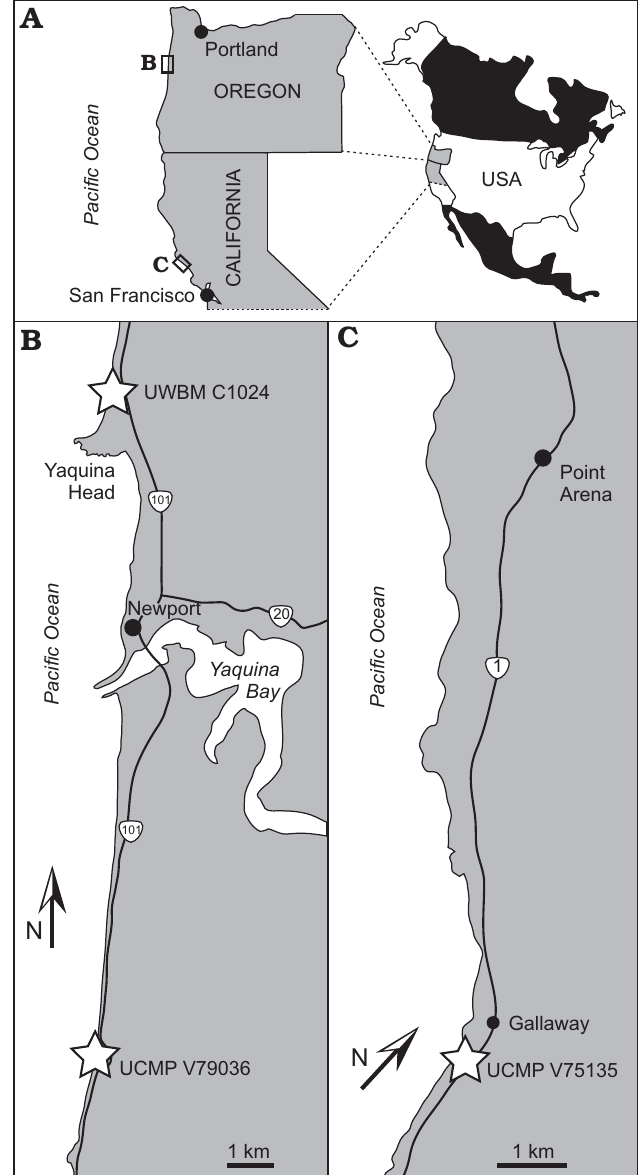
Fig. 1. Locality map for fossils of enaliarctines. Map of Oregon and Cali- fornia ( A ), the coastline near Newport, Oregon ( B ), the coastline near Point Arena, California ( C